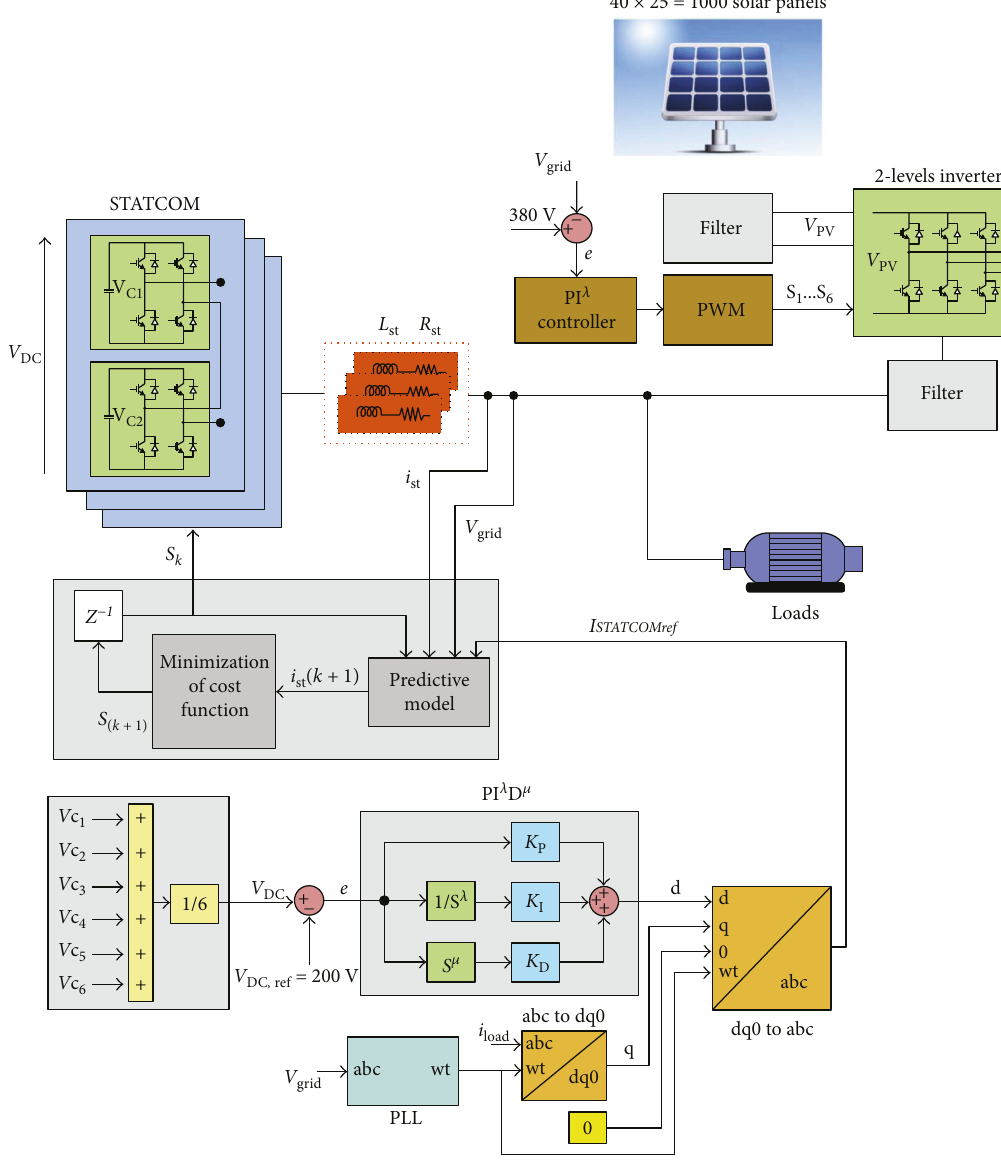
Figure 6: Block diagram of MPC for the STATCOM device. Table 2: Photovoltaic solar panel